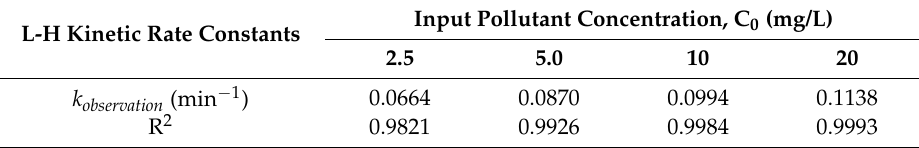
Table 2. Regression coefficients for catalytic degradation of HA and k observation .